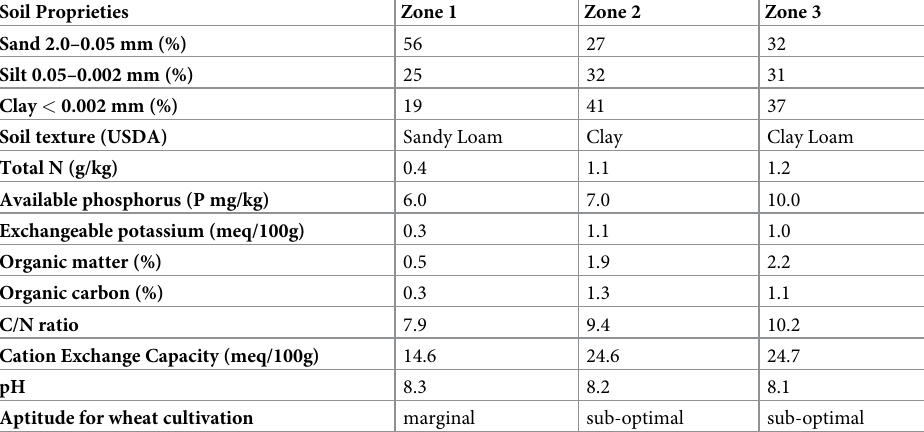
Table 2. Main soil physico-chemical characteristics of the three experimental